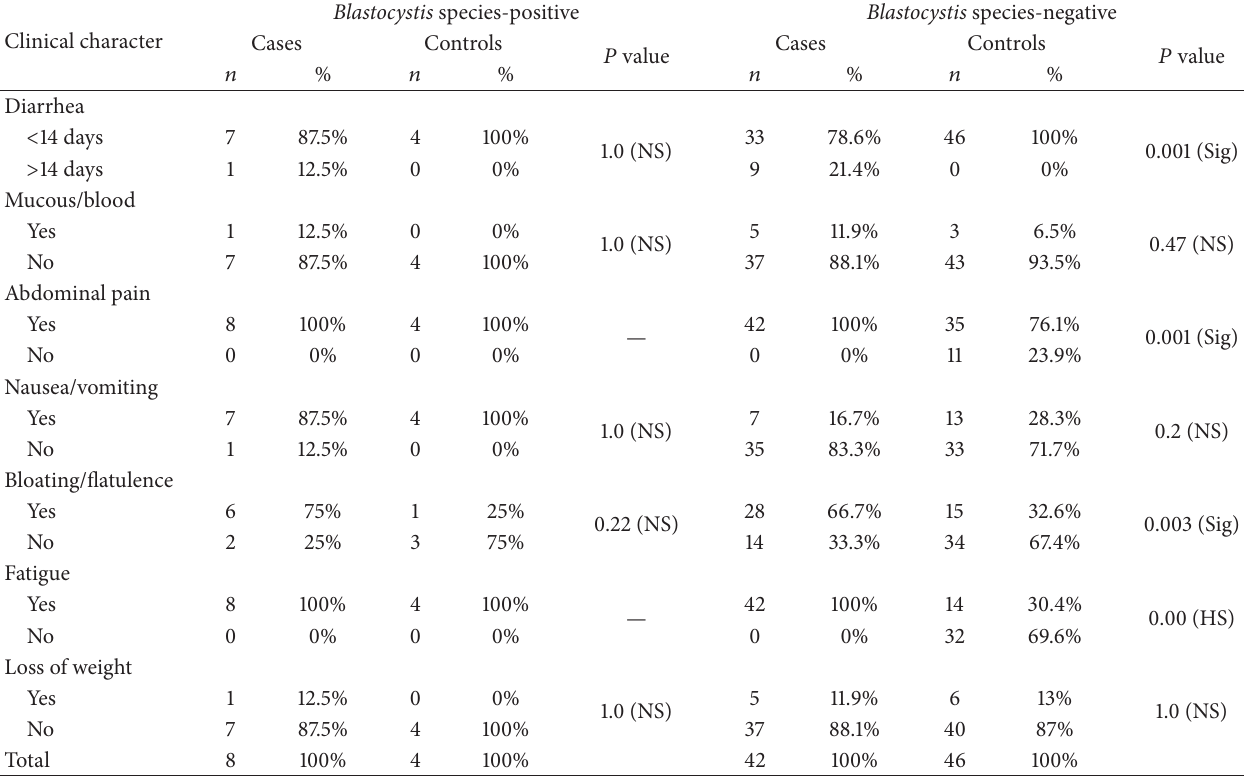
Table 3: The clinical characteristics variations among Blastocystis species positive/negative diarrheal cases and controls. Blastocystis species-positive Blastocystis species-negative Clinical character